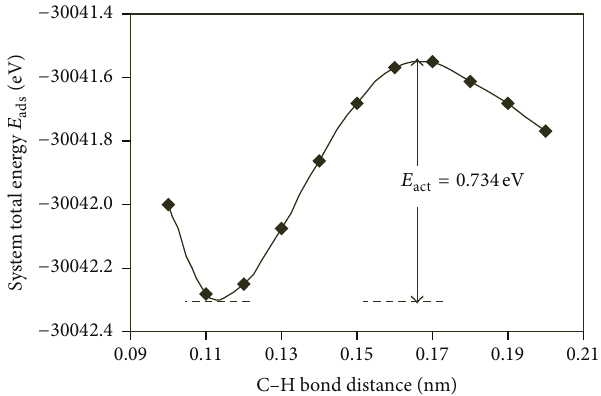
Figure 9: DFT calculated activation energy plot, 𝐸 dissociation; ∗ H 2 O → ∗ OH + ∗ H on Ni/Fe anode catalysts of various surface compositions (0% Fe, 2.8% Fe, 22.2% Fe, and 100% Fe).